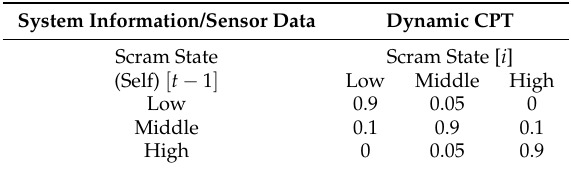
Table A3. Filled-in columns for missing information in case study dynamic conditional probability table.